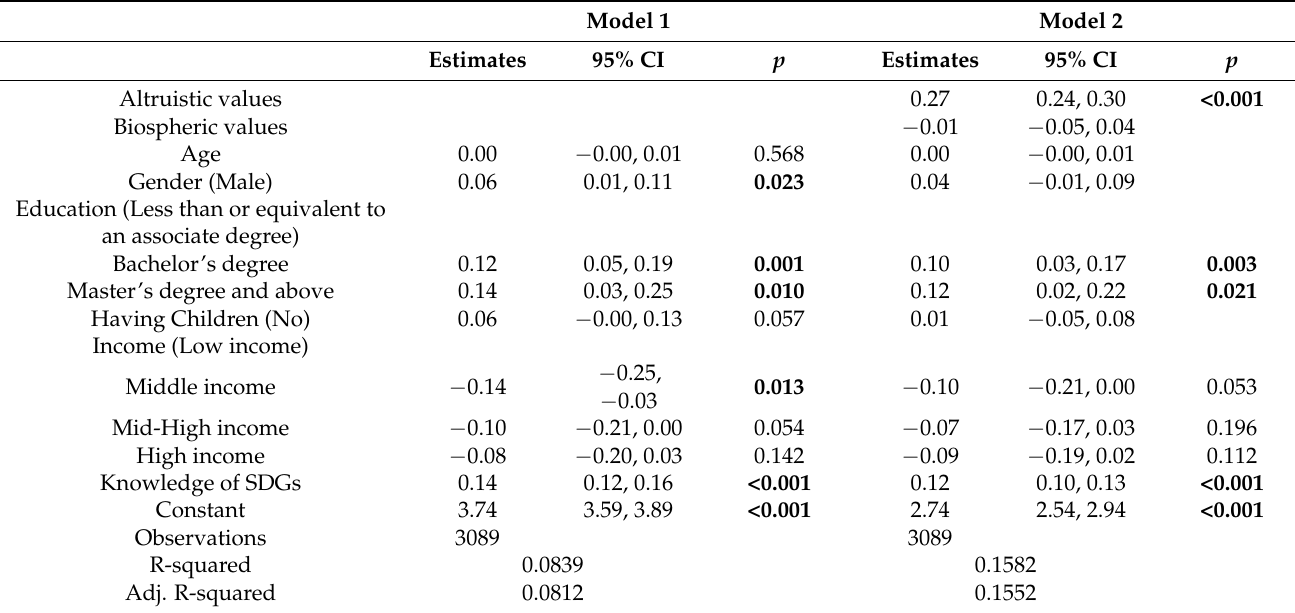
Table 3. Determinants of